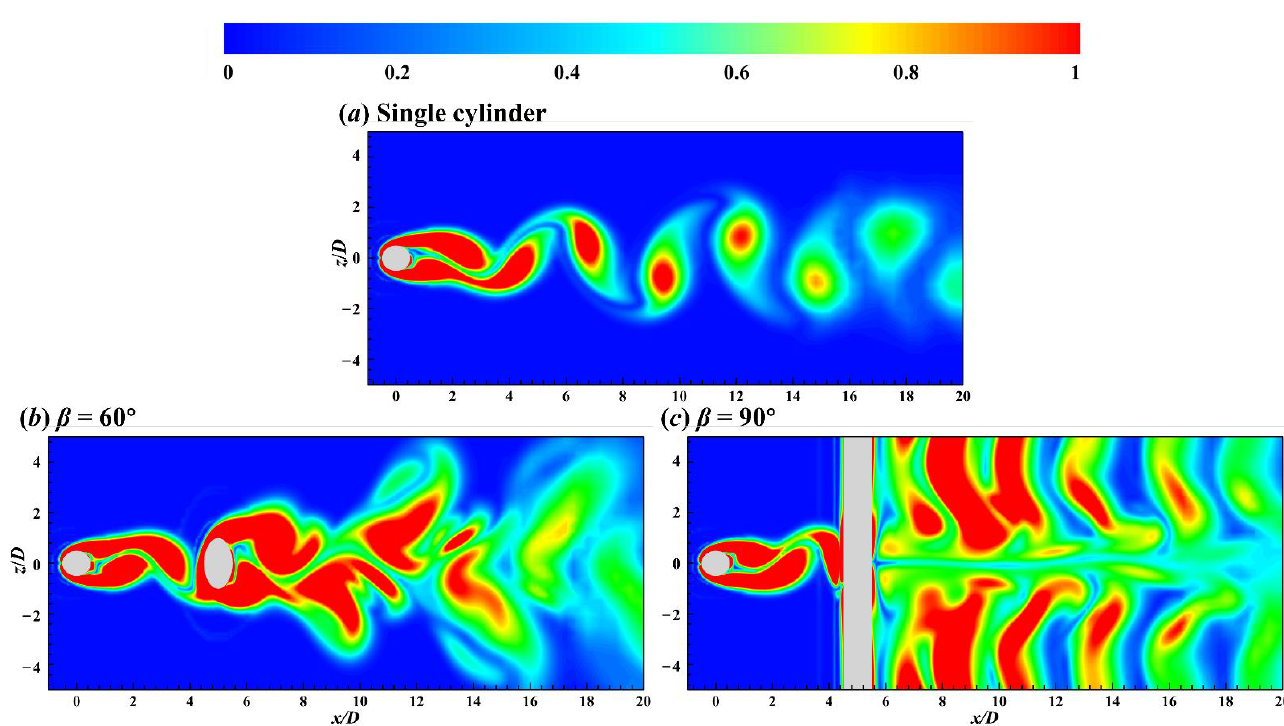
Figure 7. Contours of instantaneous vorticity magnitude on the xz plane for the flow around the single cylinder ( a ) and two crossing cylinders in 60° ( b ) and 90° ( c ) arrangements. The vorticity is normalized by U ∞ / D .